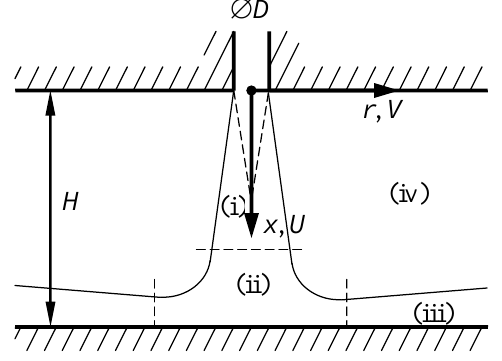
Figure 2. Description and nomenclature of the test case: Axisymmetric impinging jet flow.